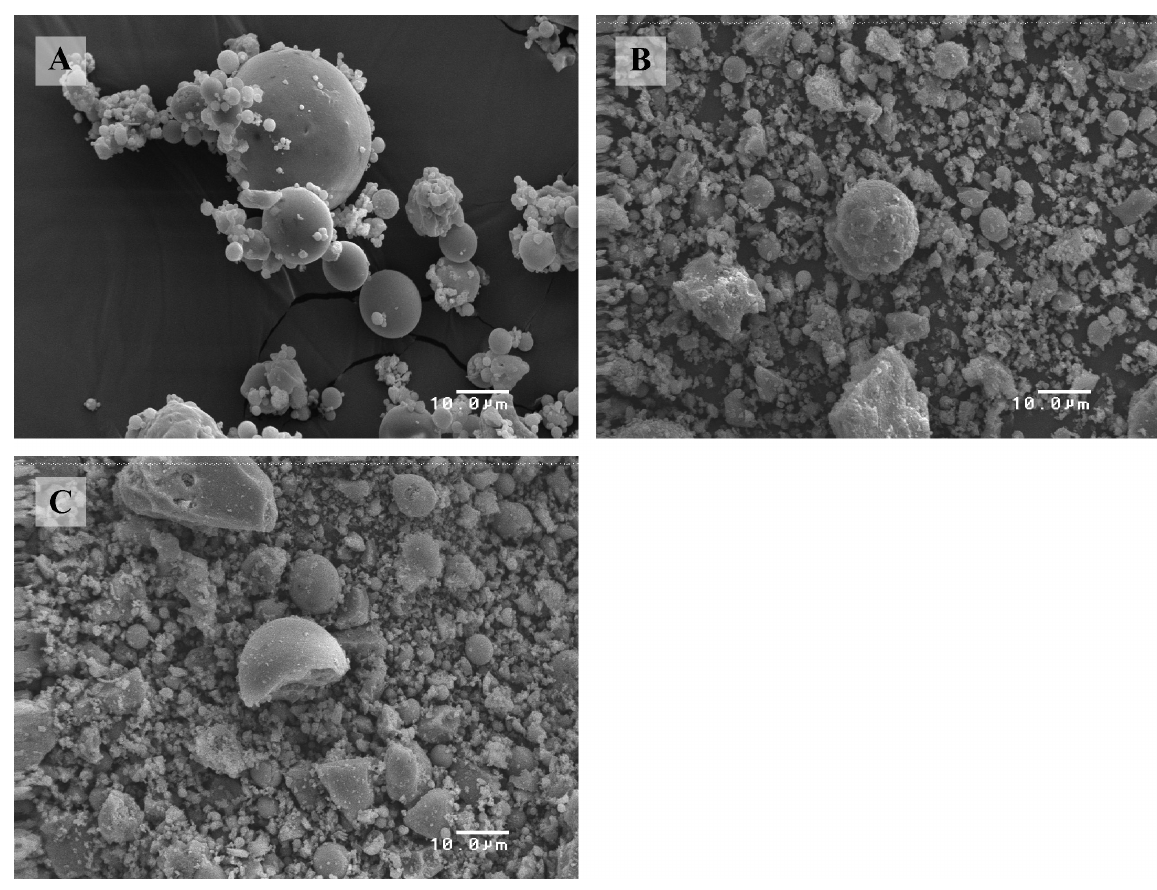
Figure 2: SEM micrographs of the raw (A), vibration (B) and attrition (C) milled fly ashes.